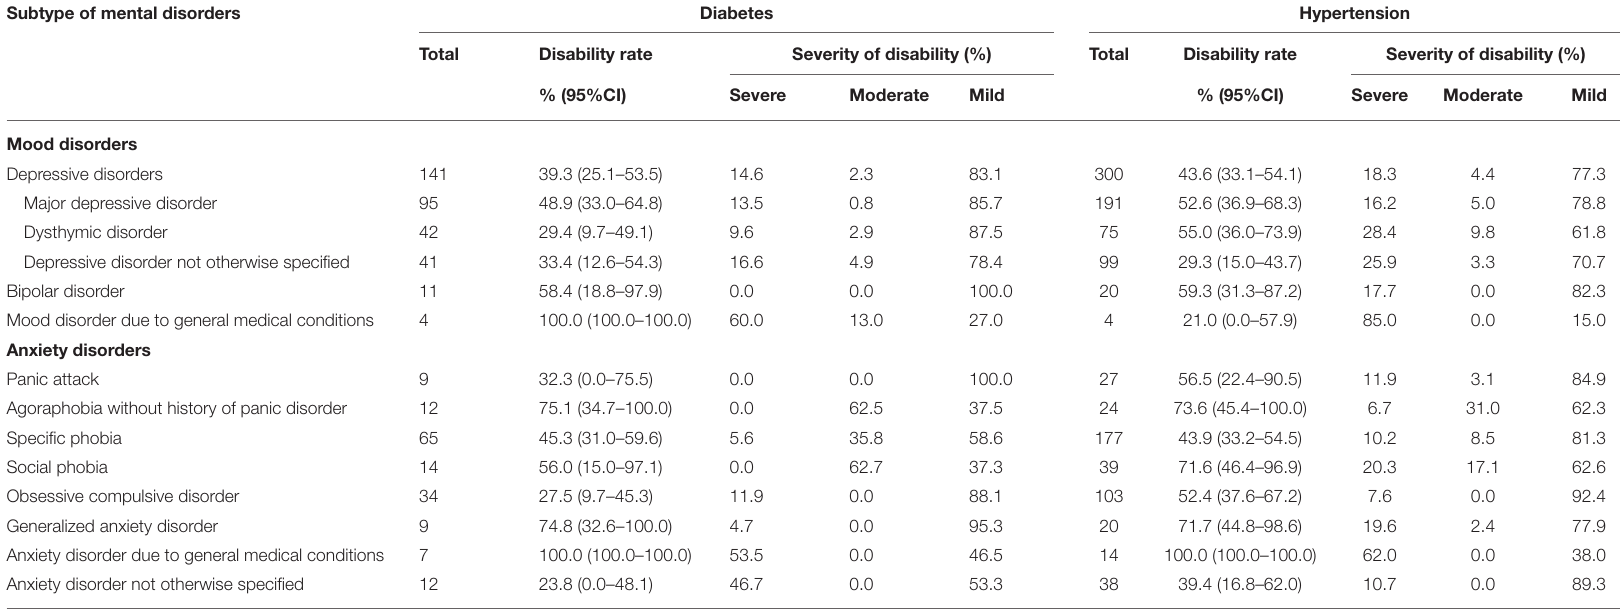
TABLE 4 | Weighted disability rates and the severity of disability among patients with each subtype of mental disorders across different comorbidity status. Subtype of mental disorders Diabetes Hypertension Total Disability rate Severity of disability (%) Total Disability rate Severity of disability